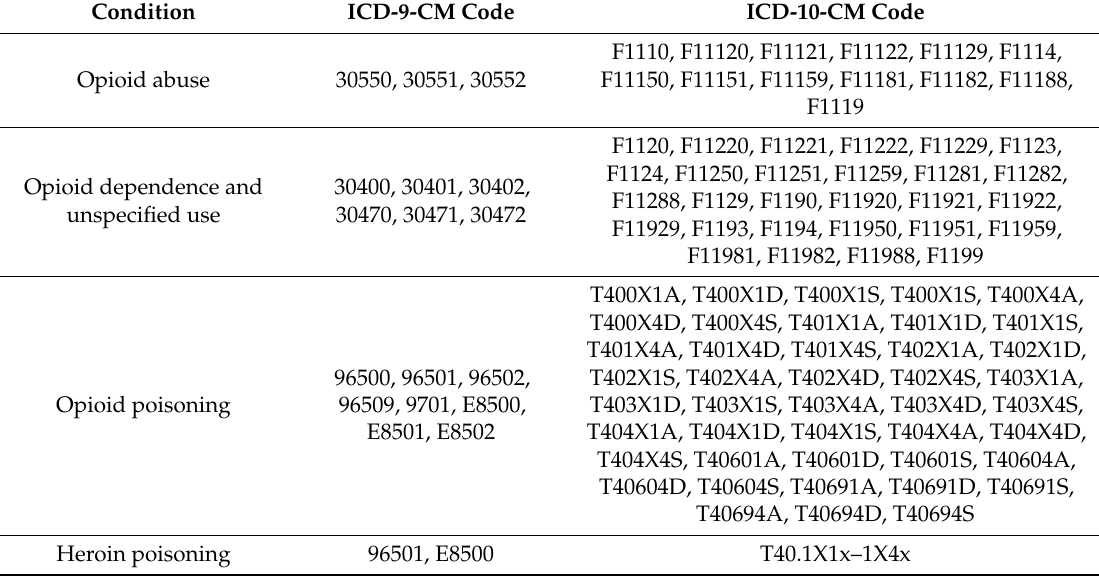
Table A2. International Classification of Diseases, 9th Revision, Clinical Modification (ICD-9-CM) and International Classification of Diseases, 10th Revision, Clinical Modification (ICD-10-CM) Codes for Opioid-Related Claims a and Heroin Overdose Used in the